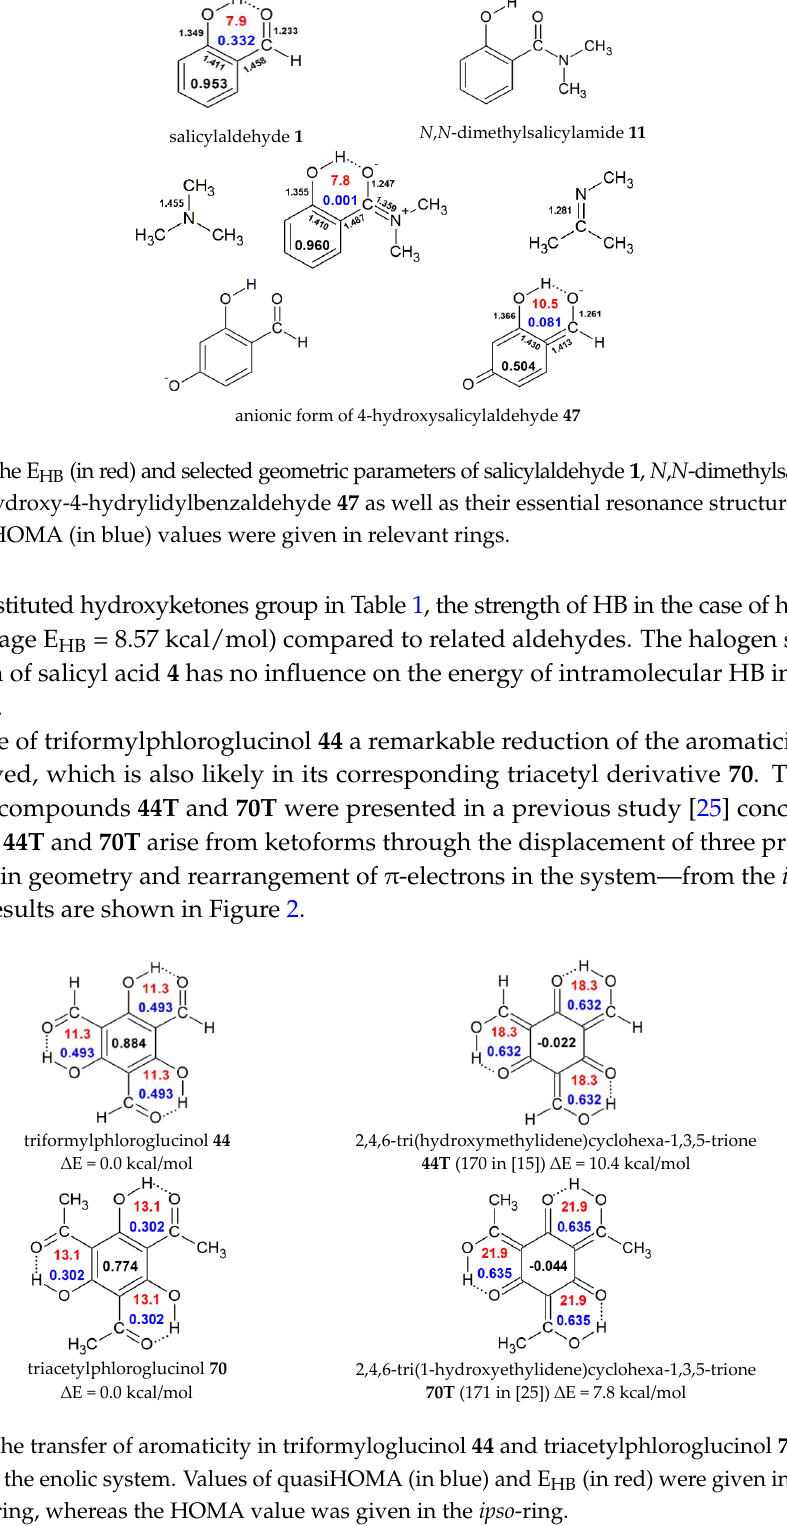
Figure 2. The transfer of aromaticity in triformyloglucinol 44 and triacetylphloroglucinol 70 from the ipso -ring to the enolic system. Values of quasiHOMA (in blue) and E HB (in red) were given in the centre of the HB-ring, whereas the HOMA value was given in the ipso -ring.